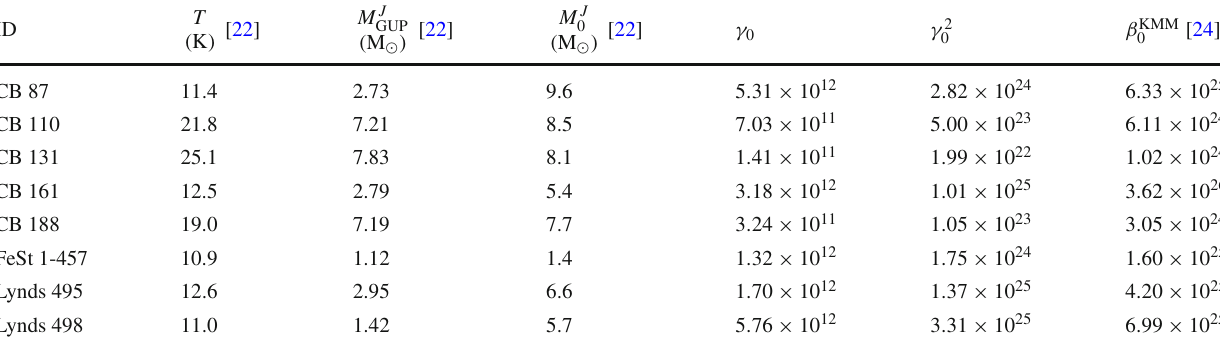
Table 1 The ID, temperature T , mass M J bound on the GUP parameter of the CH model, β KMM